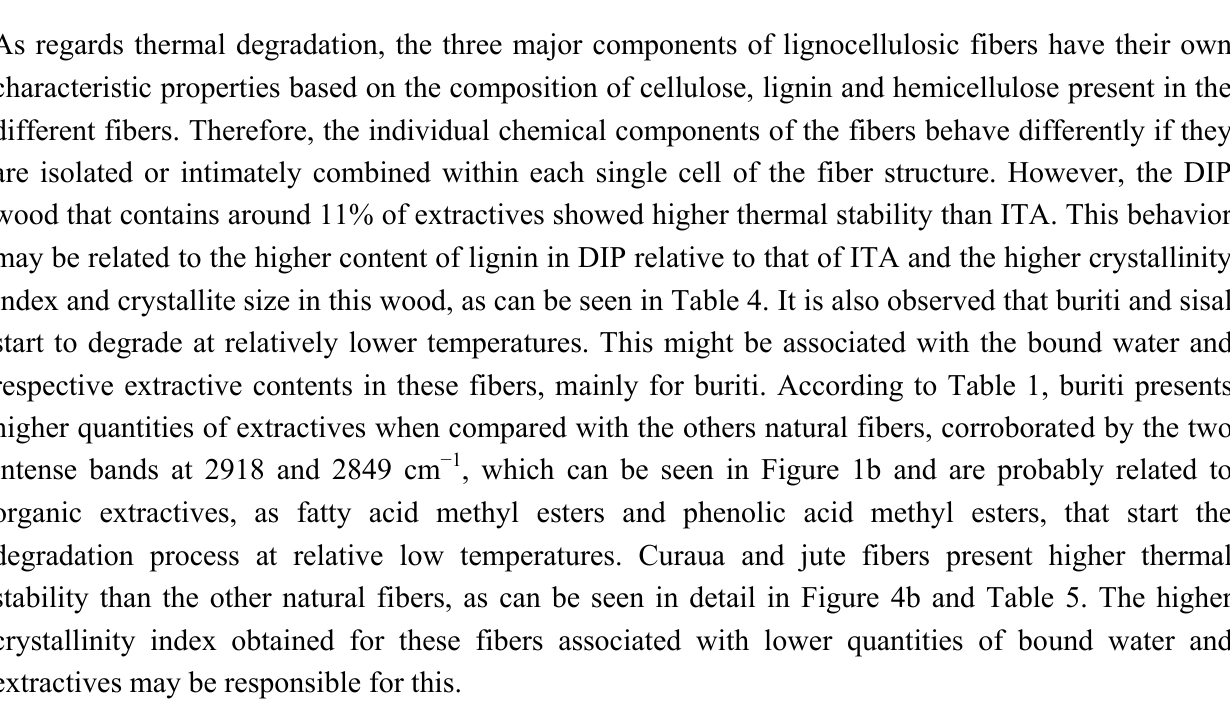
Table 5. Thermal degradation temperature and residue at 800 °C for the fibers studied.